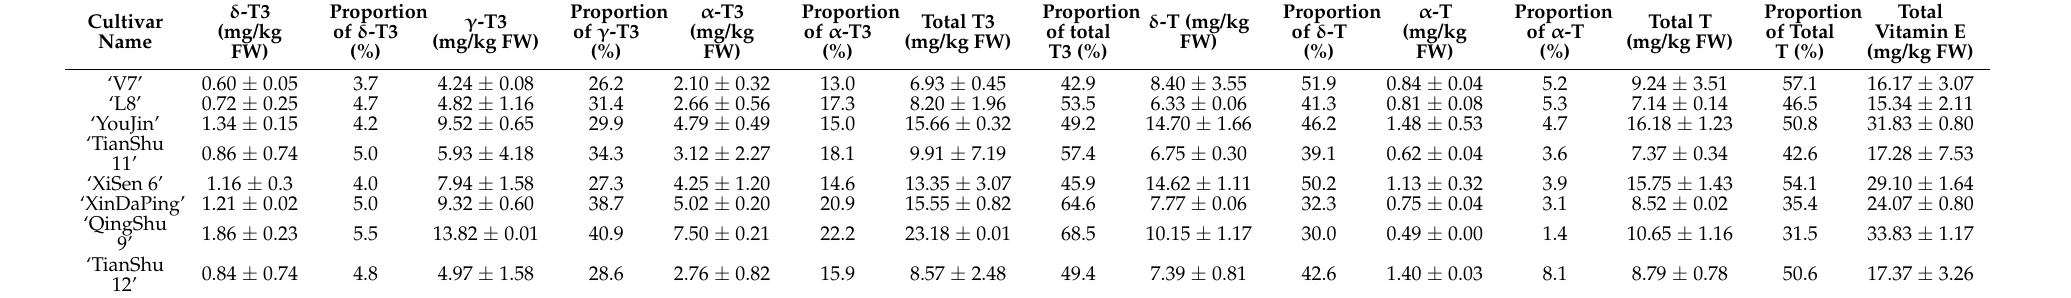
Table 4. The content of each derivative of vitamin E among raw tubers of potato